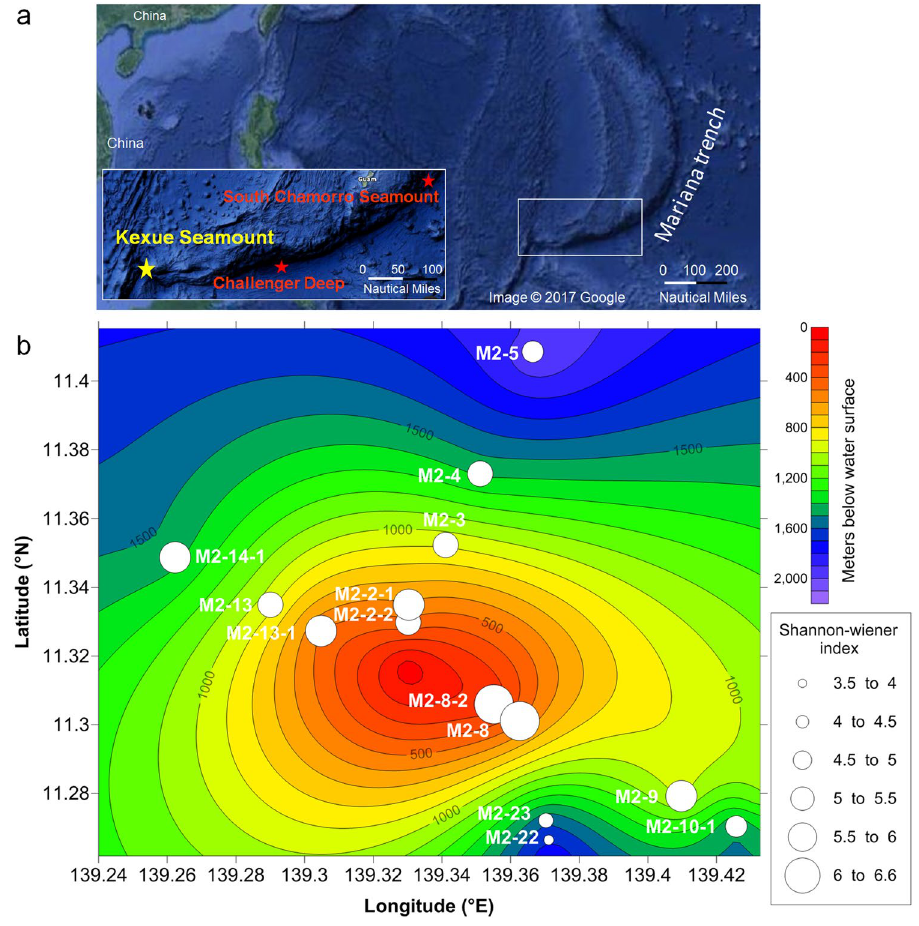
Figure 1. Sampling stations and bacterial diversity at each station. Panel ( a ) Location of the Kexue seamount (yellow stars) is shown in the insert. The South Chamorro seamount and Challenger Deep are indicated with red stars. The map data was from Imagery ©2017 Data SIO, NOAA, U.S. Navy, NGA, GEBCO, Map data ©2017 Google, ZENRIN downloaded at https://www.google.fr/maps/@11.7463718,145.5037996,1320412 m/ data = !3m1!1e3. The fourteen ROV sampling stations at the Kexue seamount are indicated with white circles and their unique station code. Panel ( b ) The diameters of the white circles are proportional to the Shannon- Wiener index for the bacteria community structure in